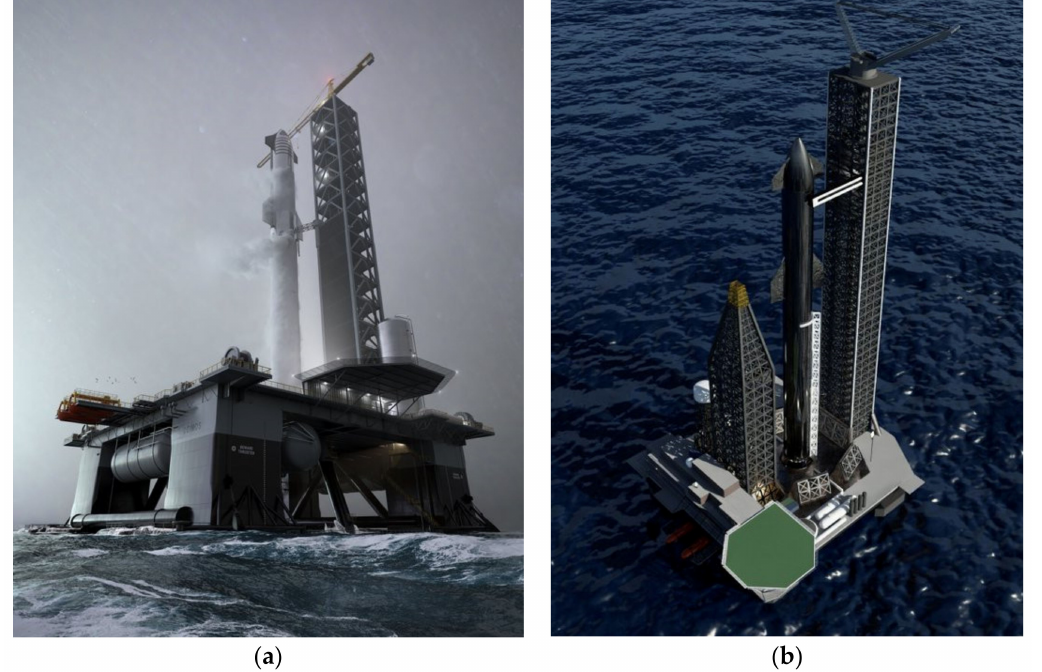
Figure 23. Rendering views of the Deimos rocket launch platform to be completed in 2022/2023, showing ( a ) the starship fueling up before liftoff on its offshore launch platform, and ( b ) the aerial view of ocean offshore spaceport Deimos (Courtesy: